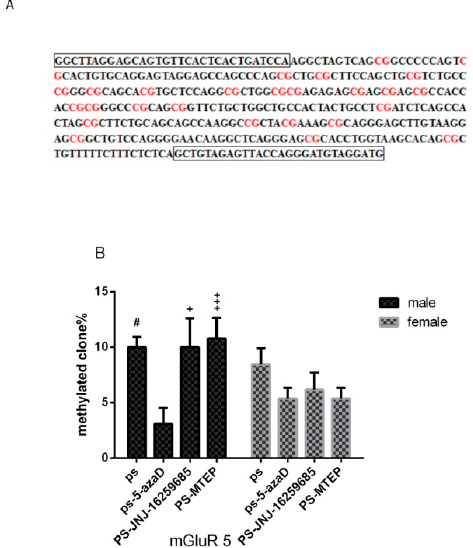
Figure 6. DNA methylation analysis of the mGluR5 gene promoter. ( A ) The design of the primer position is surrounded by the black box; ( B ) Mean + SEM percentage of methylated clones in hippocampal samples from offspring shown in four groups ( n = 5 each group). # p < 0.05 compare with CON. + p < 0.05, +++ p < 0.01 compare with PS.